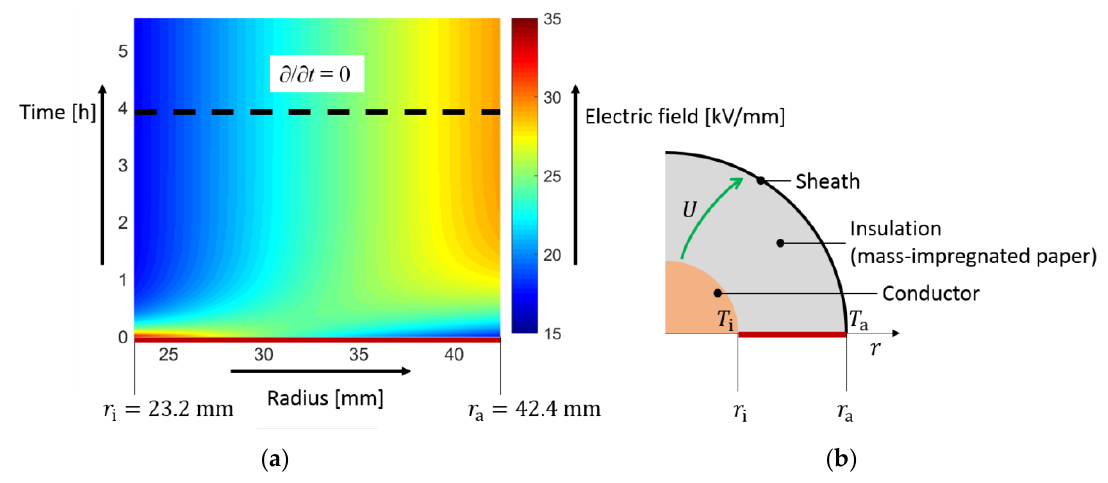
Figure 1. ( a ) Time-dependent electric field within a mass-impregnated paper (MI) insulation. The stationary electric field is obtained above the black dashed line; ( b ) geometry of the cylindrical insulation. The electric field is computed along the red evaluation line [11,13].